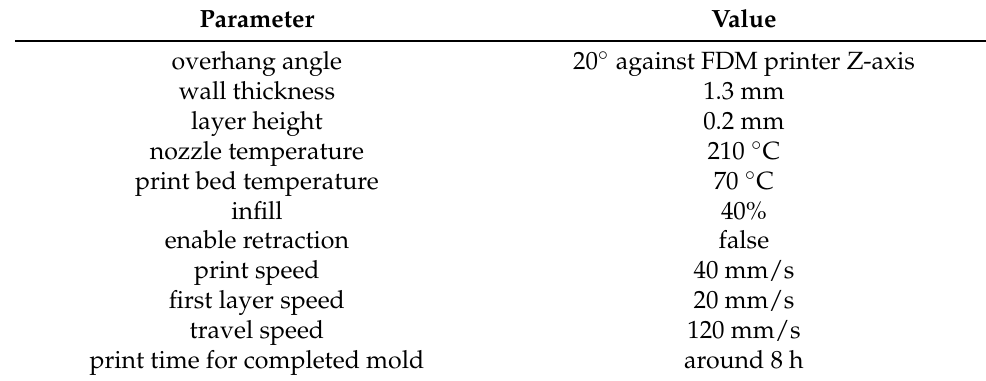
Table 2. Overview over the resulting design and printing parameters.